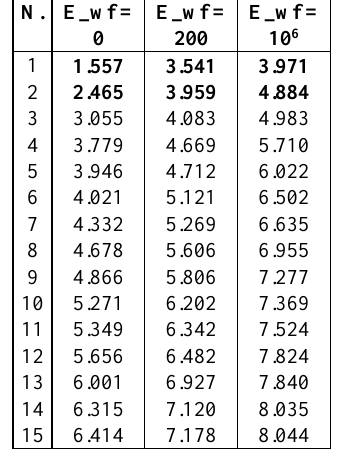
Table 1. Vibrating frequencies of the first 16 modal shapes of the “Sala dei Gessi”, with different in-aggregate restraint conditions (from isolated to fully constrained).